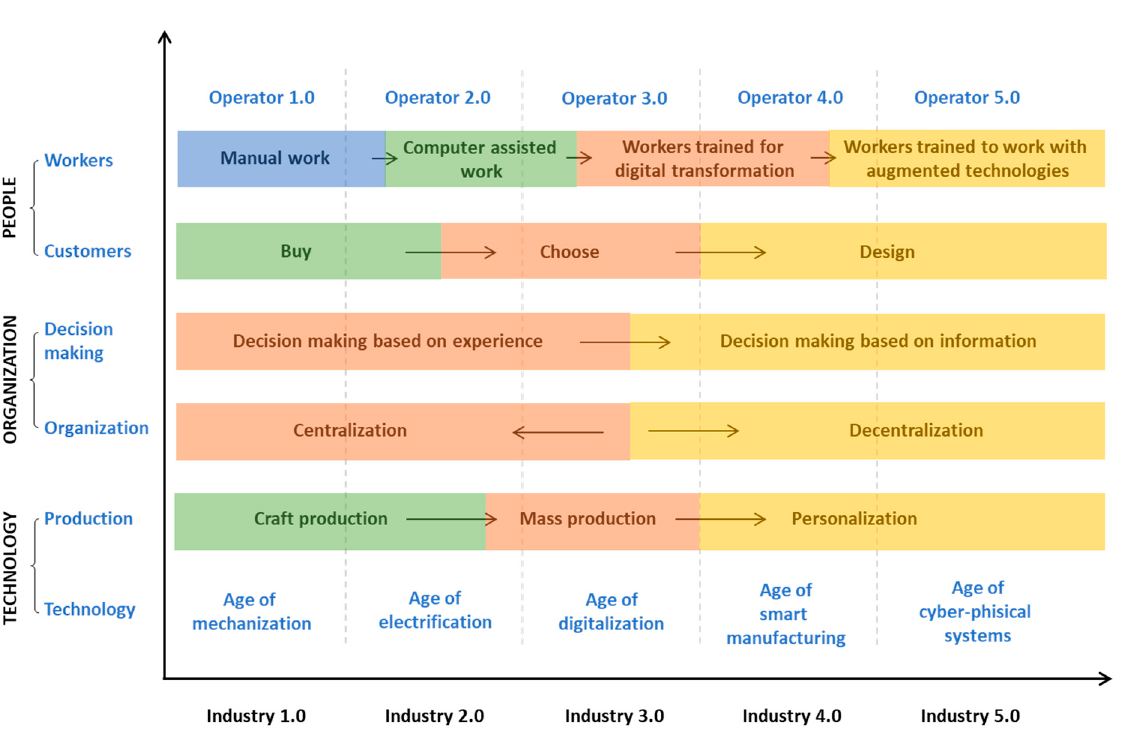
Figure 1. Transformations through the paradigms according to the important participants and seg- ments of industries.